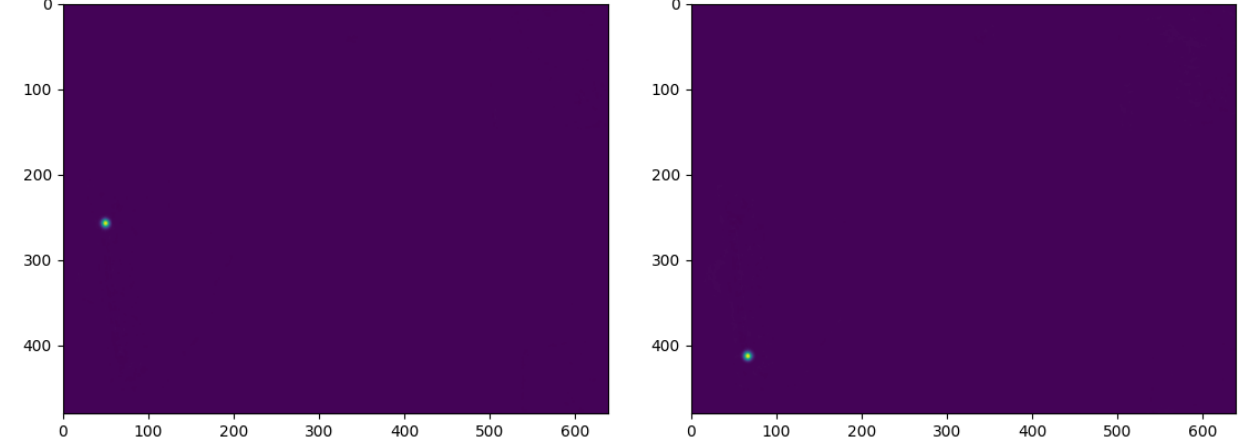
Figure 18. Heatmap of test image in DB-25 dataset.